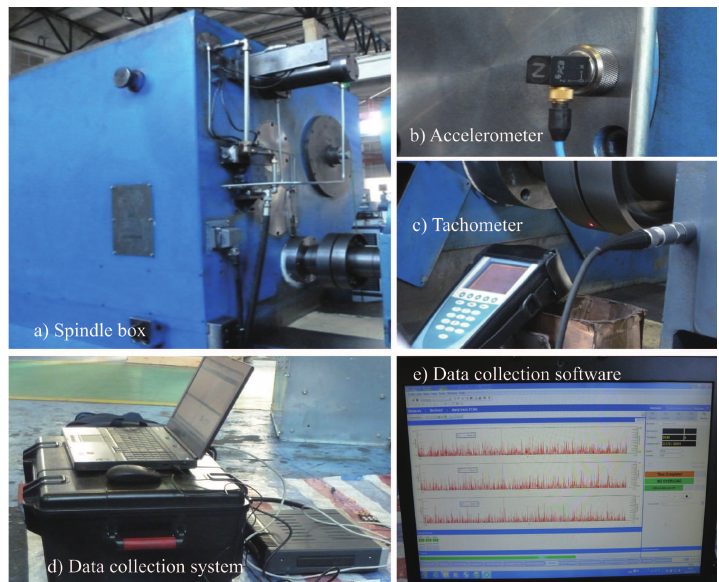
Figure 5. Sensors and signal acquisition equipment. ( a ) Spindle box. ( b ) Accelerometer. ( c ) Tachometer. ( d ) Data collection system. ( e ) Data collection